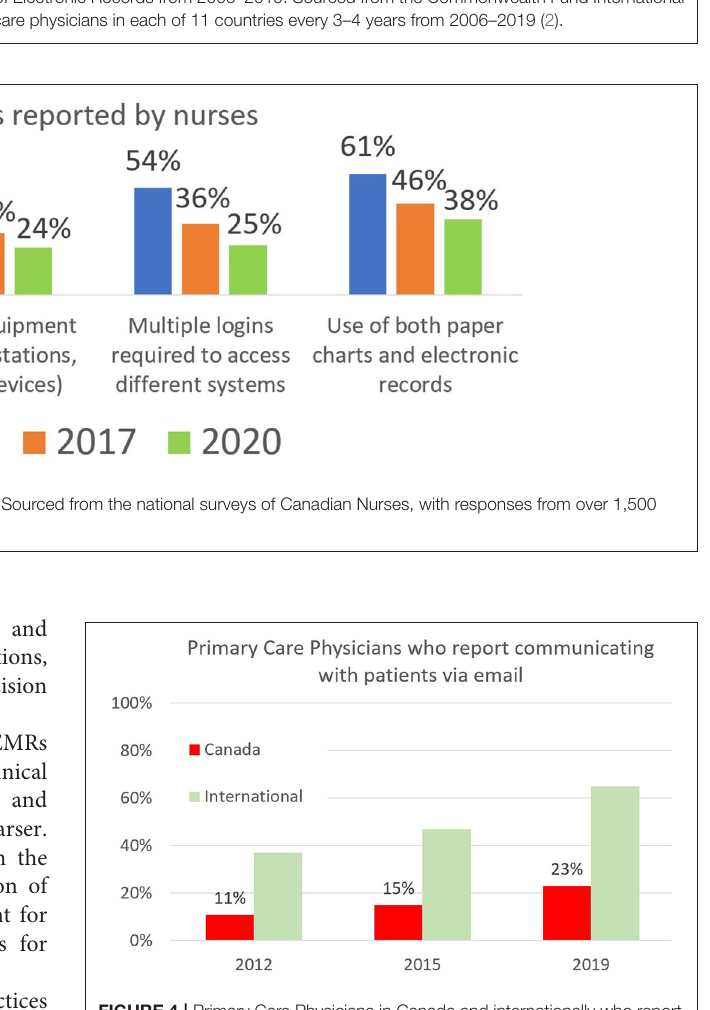
FIGURE 4 | Primary Care Physicians in Canada and internationally who report offering patients the option to communicate via email from 2012–2019. Sourced from the Commonwealth Fund International Survey of Primary Care Physicians, which surveyed 500 or more primary care physicians in each of